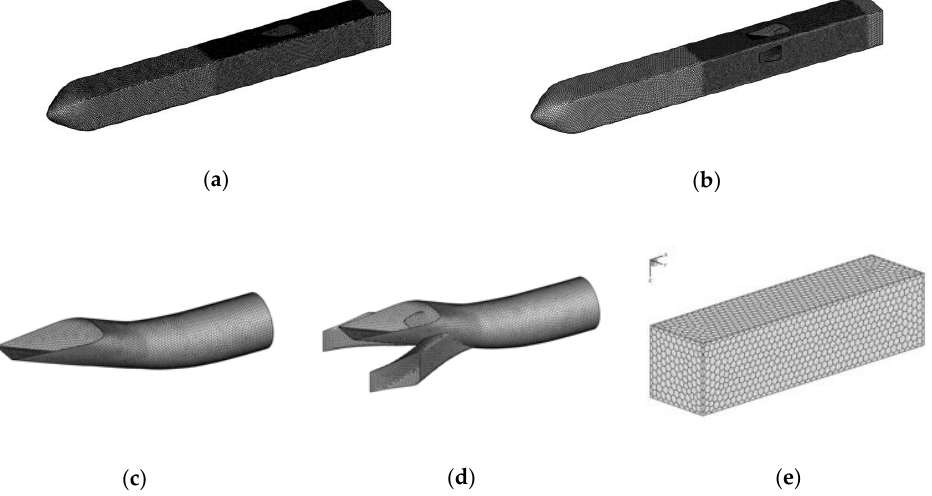
Figure 4. Surface mesh of projectile body, inlet, and far-field. (( a ) Surface mesh of missile body in the conventional inlet, ( b ) Surface mesh of missile body in the distributed inlet, ( c ) Surface mesh of the conventional inlet, ( d ) Surface mesh of the distributed inlet, ( e ) Surface mesh of far-field)